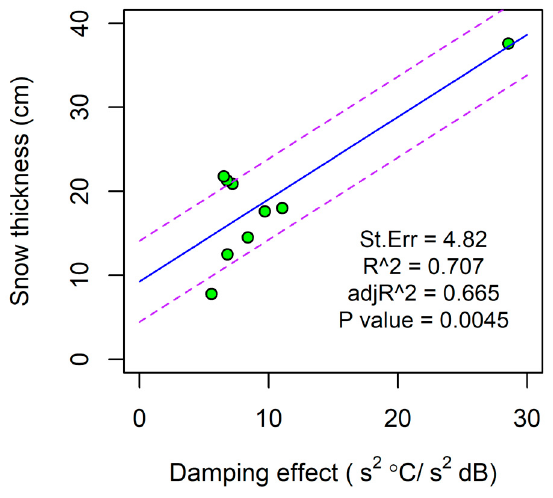
Figure 8. Damping effect versus snow thickness for all ASCAT samples. The blue line is a linear regression and the dashed purple lines represent the standard error of the regression.